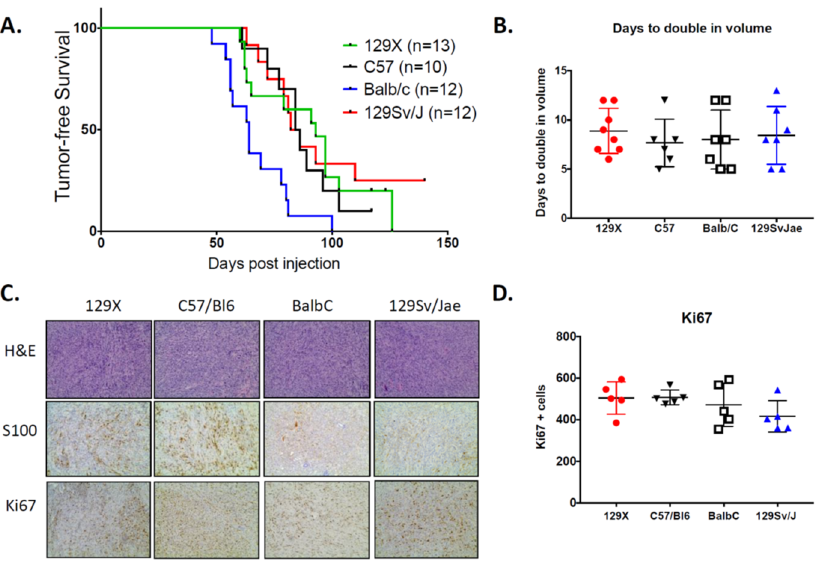
Figure 1. Host strain determines tumor onset but does not alter tumor growth kinetics. ( A ) Kaplan– Meyer curve of tumor-free survival. Formation of Nf1/p53 -deleted malignant peripheral nerve sheath tumors (MPNSTs) is accelerated in BALB/c mice. Tumor initiation occurs within a similar timeframe in mice from 129/SvJae, C57BL/6, and 129X1 backgrounds. ( B ) Growth kinetics are similar across all background strains for genetically-identical MPNSTs ( n = 6–8 tumors per strain). Growth rates are calculated as the number of days required for tumors to double from an initial volume of 150 mm 3 . 129X1 (red circles), C57BL/6 (black triangles), BABL/c (white squares), and 129/SvJae (blue triangles). ( C ) Representative images of MPNSTs from different host strains stained for H&E (20×), S100 (20×), and Ki67 (20×). ( D ) Quantification of Ki67 confirms that background strain does not alter the rate of tumor proliferation ( n = 5 tumors per strain). ( B , D ) analyzed by one-way ANOVA with Tukey’s multiple comparison test.